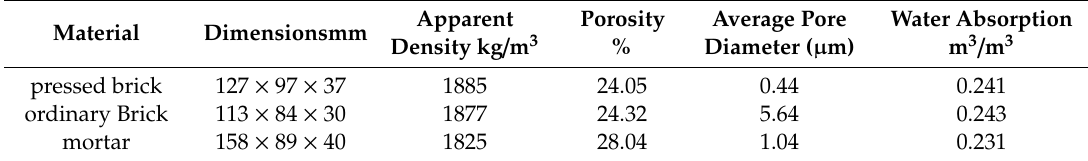
Table 1. Material test values.